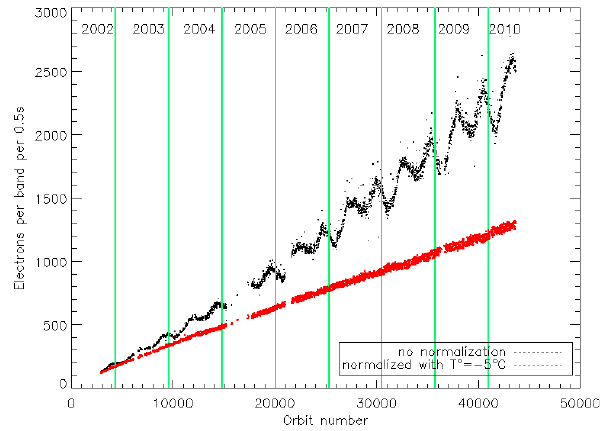
Fig. 1. Dark charge time evolution given by the CCD detector when the instrument is running on a calibration mode when the instrument is not pointing at any star called “dark sky area” measurement (dark dots). The oscillation is due to CCD temperature fluctuations. The normalized noise (red dots) is also indicated. This corresponds to the residual noise after the dark charge noise is corrected for tem- perature